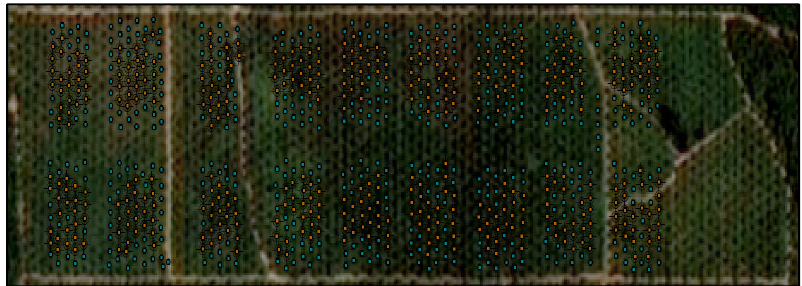
Figure 4. Map of the selected oil palms for leaf sampling.